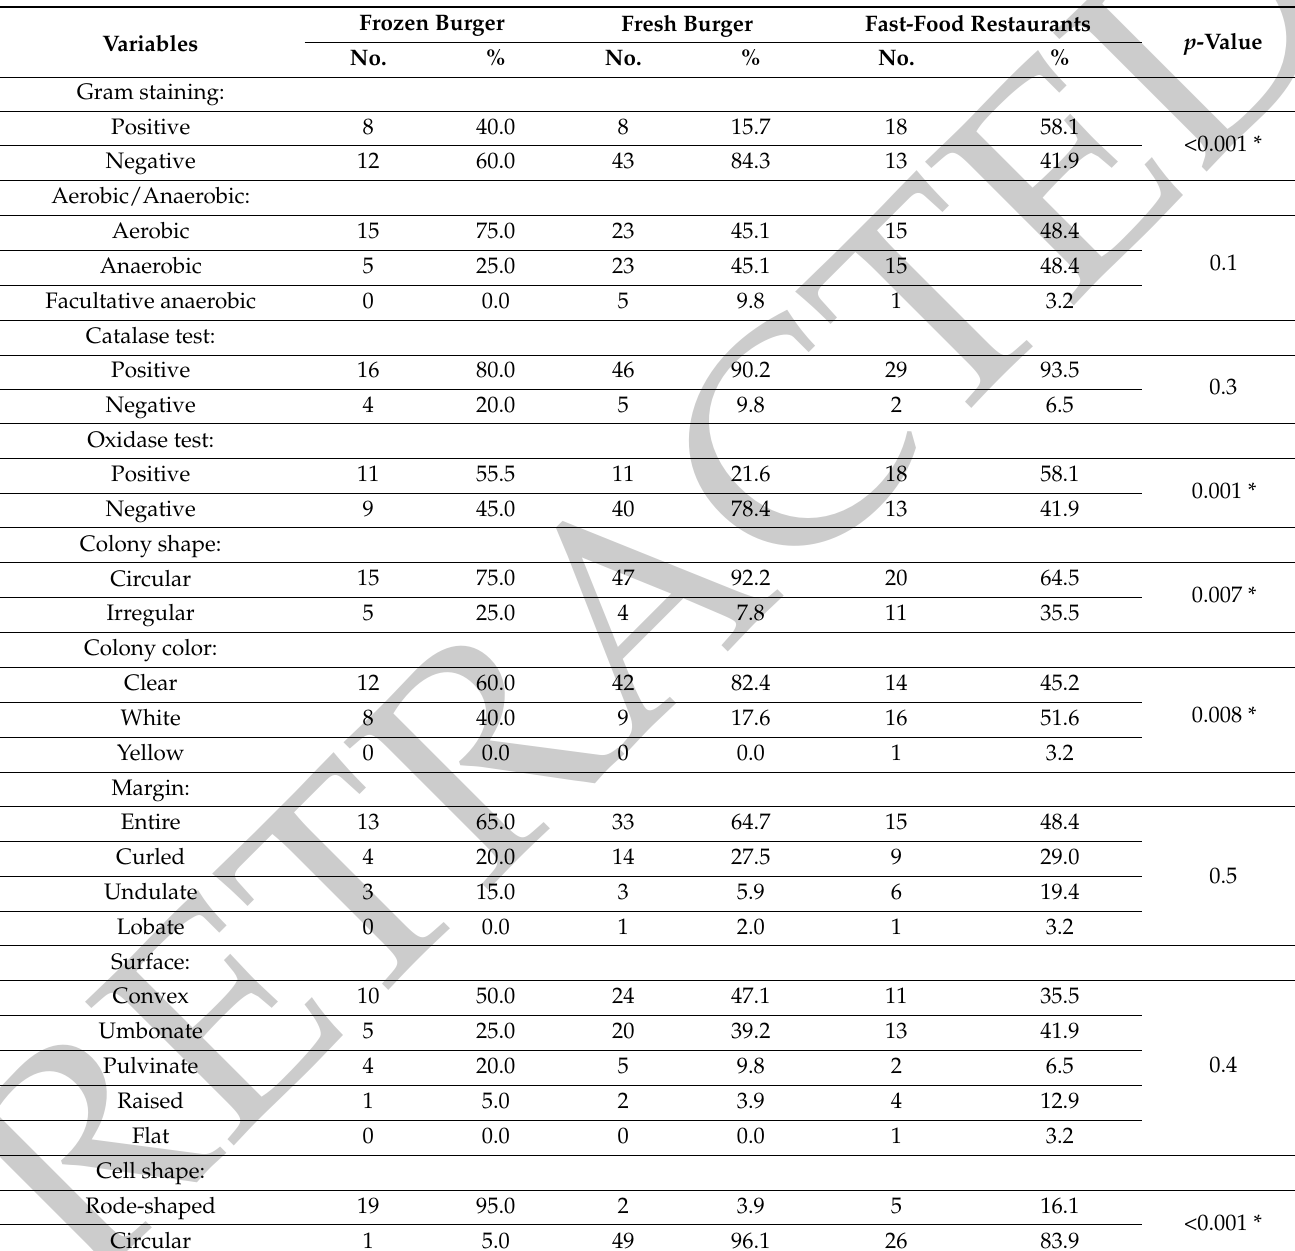
Table 4. Comparison between the different types of the sample regarding staining, biochemical and Phenotypic features of isolates. Frozen Burger Fresh Burger Fast-Food Restaurants Variables